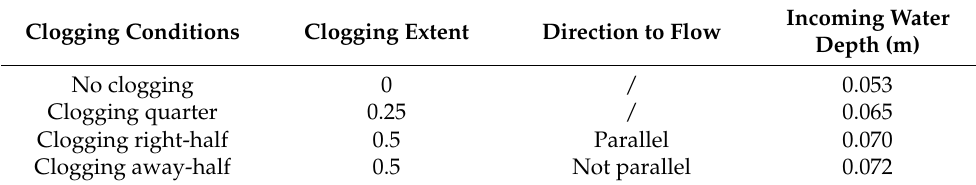
Table 3. Incoming critical state water depth under different clogging conditions.